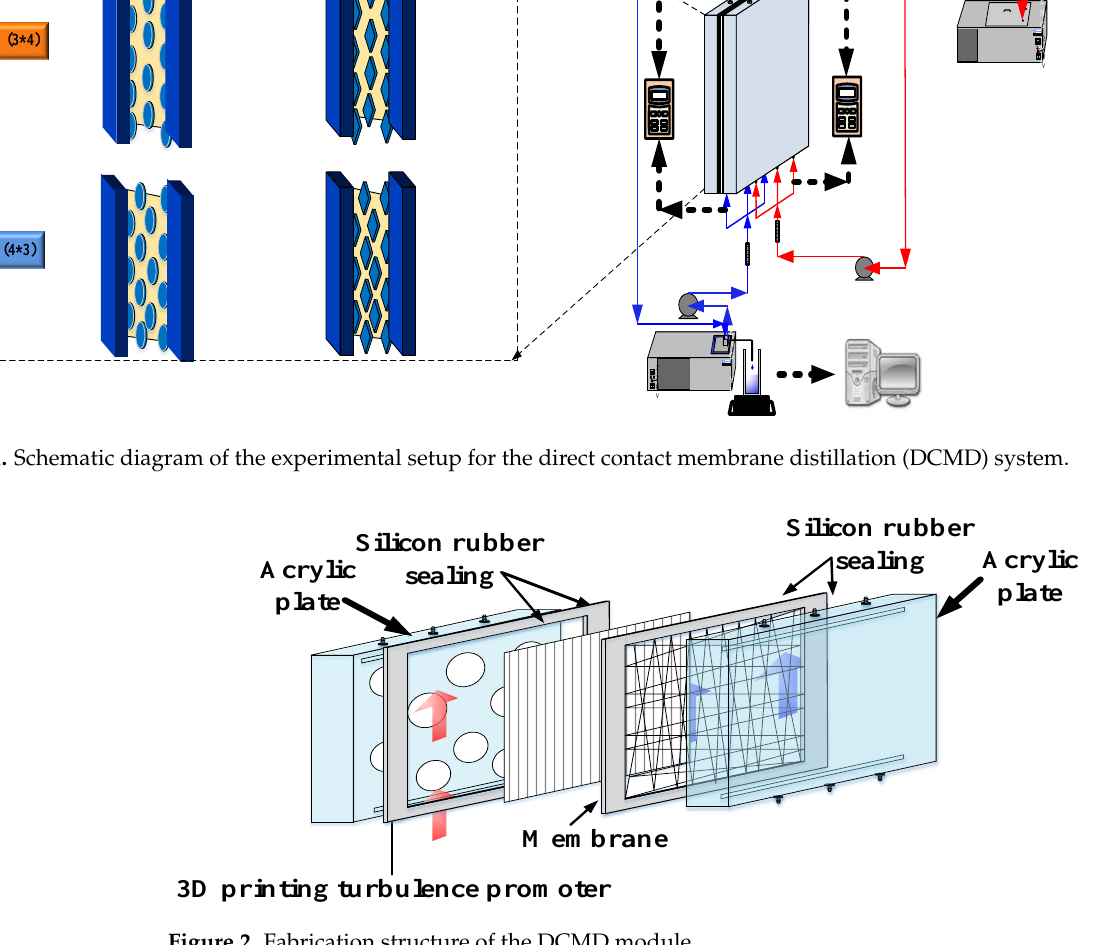
Figure 2. Fabrication structure of the DCMD module.